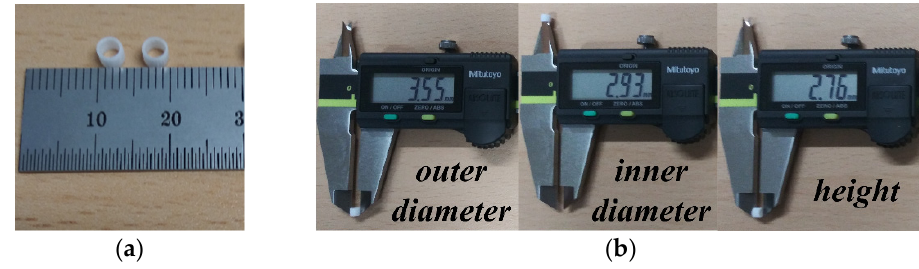
Figure 11. Fabricated liquid container: ( a ) photograph and ( b ) measured dimensions. This study next examined the effects of varying the relative permittivity of the MUT inside the liquid container on the sensitivity of the first resonant frequency for the scaled radiating edge ‐ aligned SR ‐ CSRR ‐ BCS slot ‐ loaded MPA when the liquid container was placed at the center of the top edge (Figure 12a). The relative permittivities of the MUT inside the liquid container for the simulation were 1, 2, 4, 6, 8, and 10, which were used for the MUT superstrate. In addition, the relative permittivities of ethanol, methanol, and water, which were selected for testing polar liquids to cover a broad range of high relative permittivity and high loss tangents, were also considered. Table 3 lists the relative permittivity and loss tangent values of ethanol, methanol, and water at 2.5 GHz and 25 °C [39,40]. Figure 12 presents the simulation results of the input reflection coefficient characteristics, the values of the first resonant frequency, and PRFS of the first resonant frequency of the scaled SR ‐ CS ‐ BCS slot ‐ loaded MPA with the liquid container at the center of the top edge.